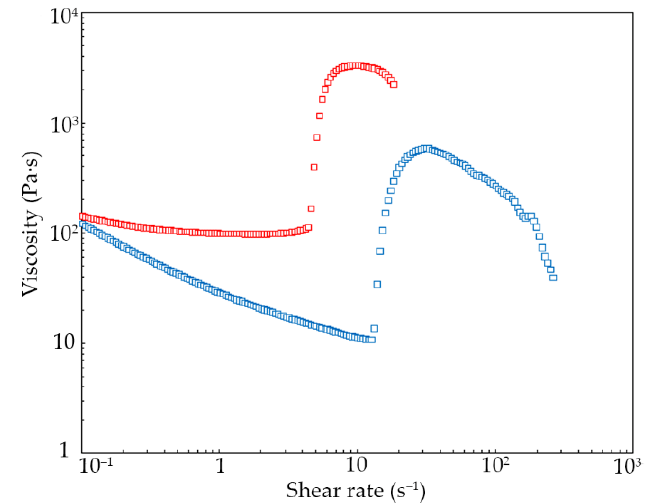
Figure 3. Viscosity vs. shear rate for the investigated STFs: blue squares STF425, red squares STF2700.